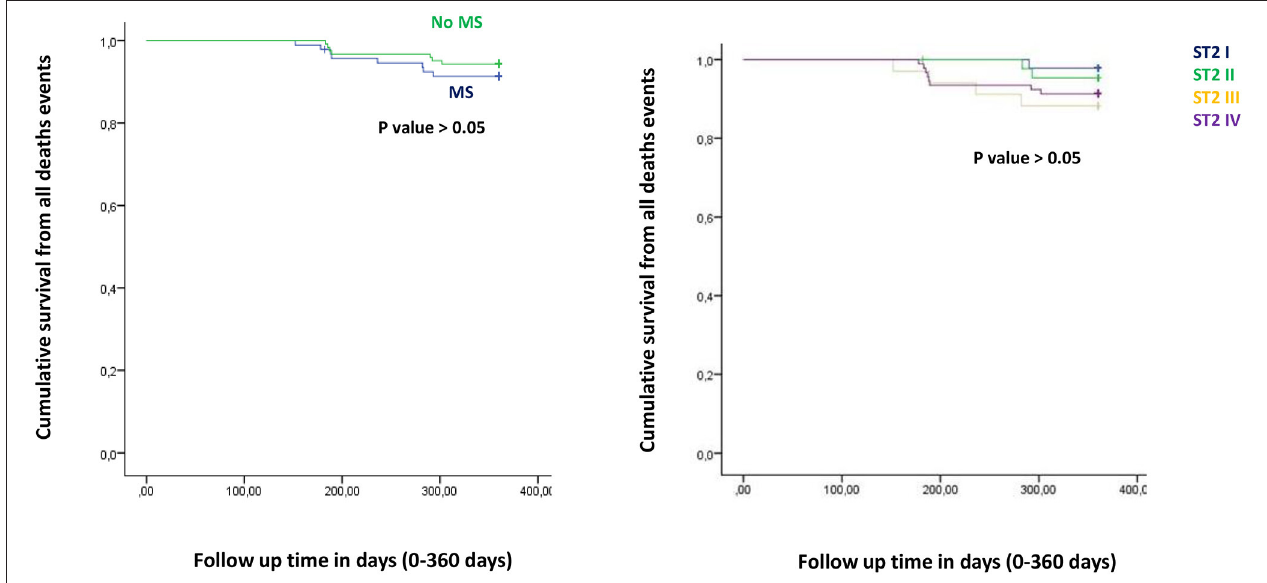
FIGURE 1 | The curve representation of all deaths events as “cumulative survival from all deaths events” (on y axis) during 360 days follow up (on x axis) comparing MS vs. no MS patients (left part), and different quartiles (right part).